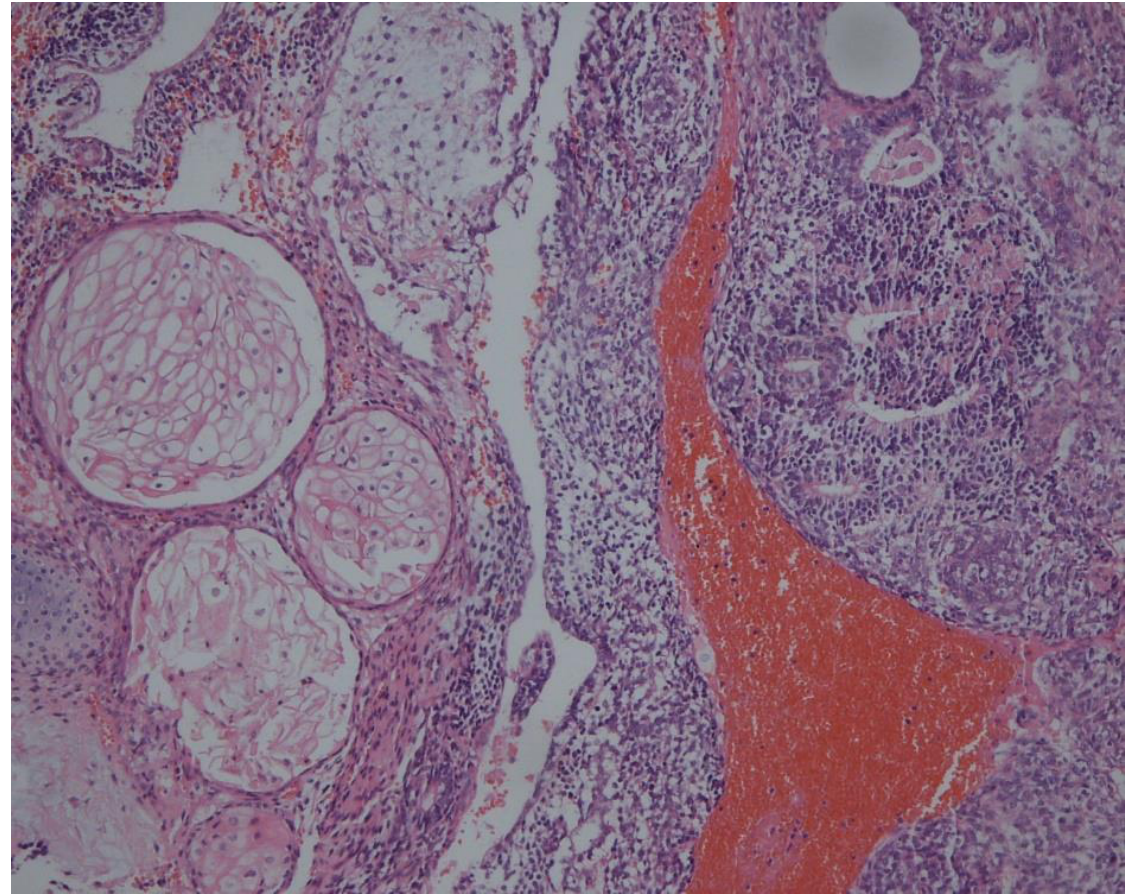
Figure 1. Paraffin pathology confirmed that most of the right ovarian tumor was composed of mature teratoma with focal primitive neuroepithelial elements (HE staining, 20×).